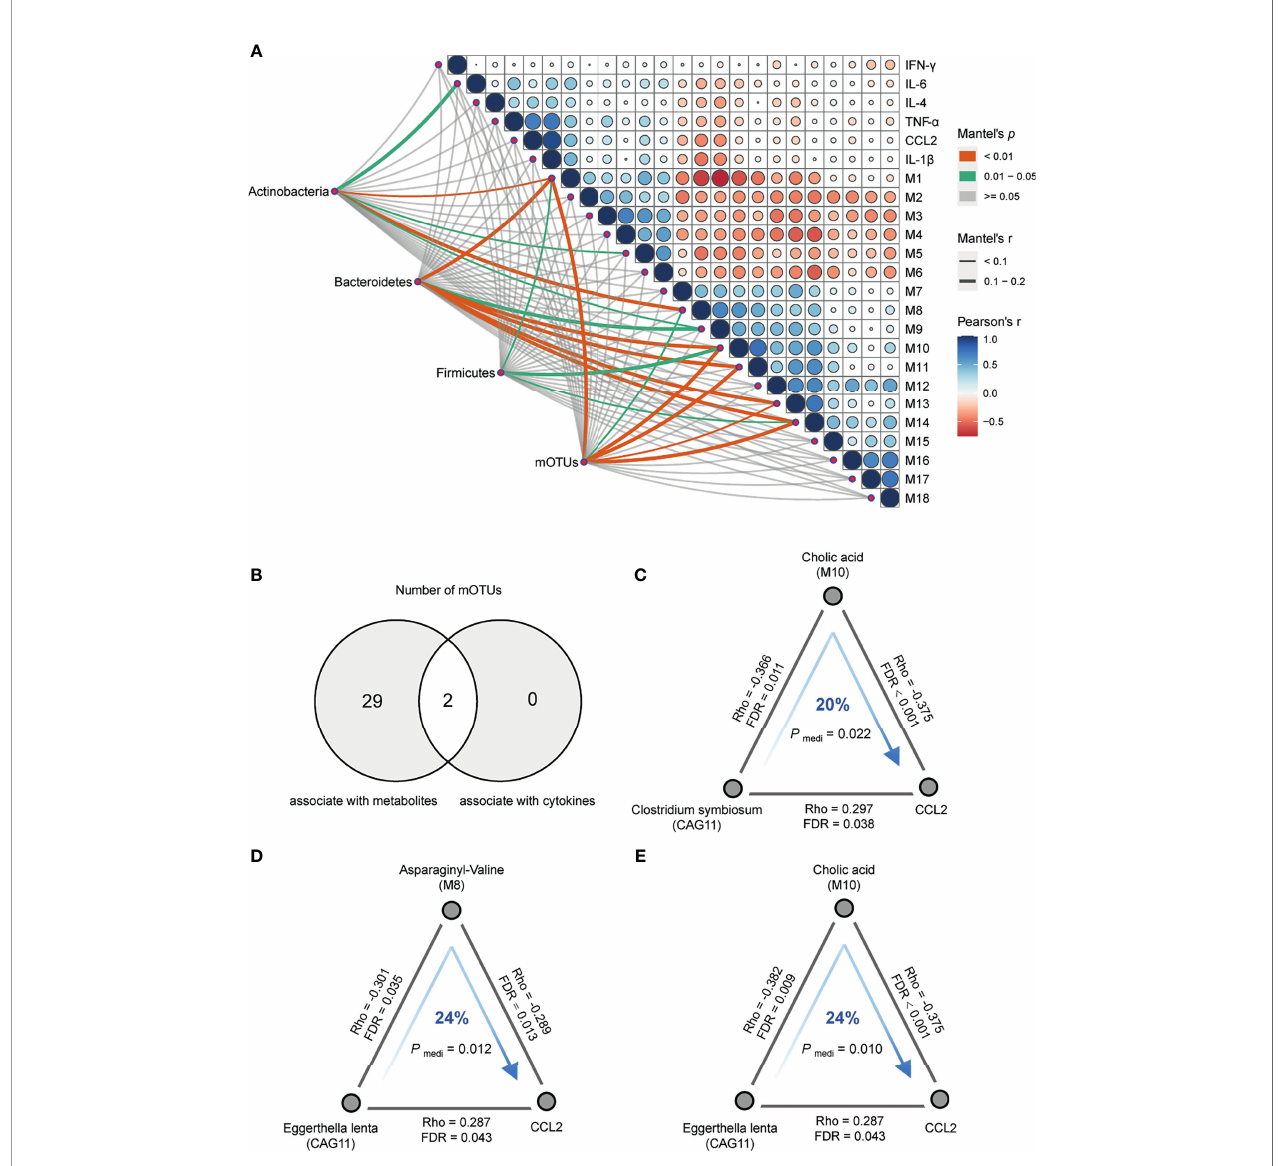
FIGURE 4 | Correlation analysis of multi-omics. (A) Pairwise comparisons of metabotypes and cytokines were shown, with a color gradient denoting Pearson ’ s correlation coef fi cients. Actinobacteria, Bacteroidetes, Firmicutes, and mOTUs were related to each metabotypes and cytokines by partial (age, sex, BMI and diet- corrected) Mantel tests. Edge width corresponded to the Mantel ’ s r statistic for the corresponding metabotypes and cytokines correlations, and edge color denoted the statistical signi fi cance based on 9,999 permutations. (B) Venn plot of the number of differentially abundant mOTUs that were associated with serum metabolites and cytokines, respectively. (C) Clostridium symbiosum contributed to C – C motif chemokine ligand 2 (CCL2) through cholic acid (P mediation = 0.022, 20%). (D) Eggerthella lenta contributed to CCL2 through asparaginyl-valine (P mediation = 0.012, 24%). (E) Eggerthella lenta contributed to CCL2 through cholic acid (P mediation = 0.010, 24%). The gray lines indicated the Spearman correlations adjusting for age, sex, BMI and diet, with corresponding rho coef fi cients and false discovery rate values. The blue arrowed lines indicated the microbial effects on CCL2 mediated by metabolites, with the corresponding mediation P-